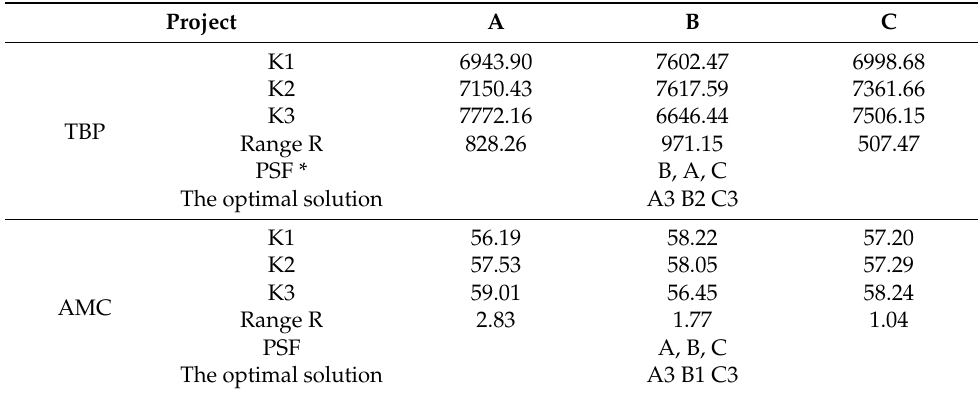
Table 5. Range analysis of total biogas production and average methane concentration in biogas residue from pig manure anaerobic